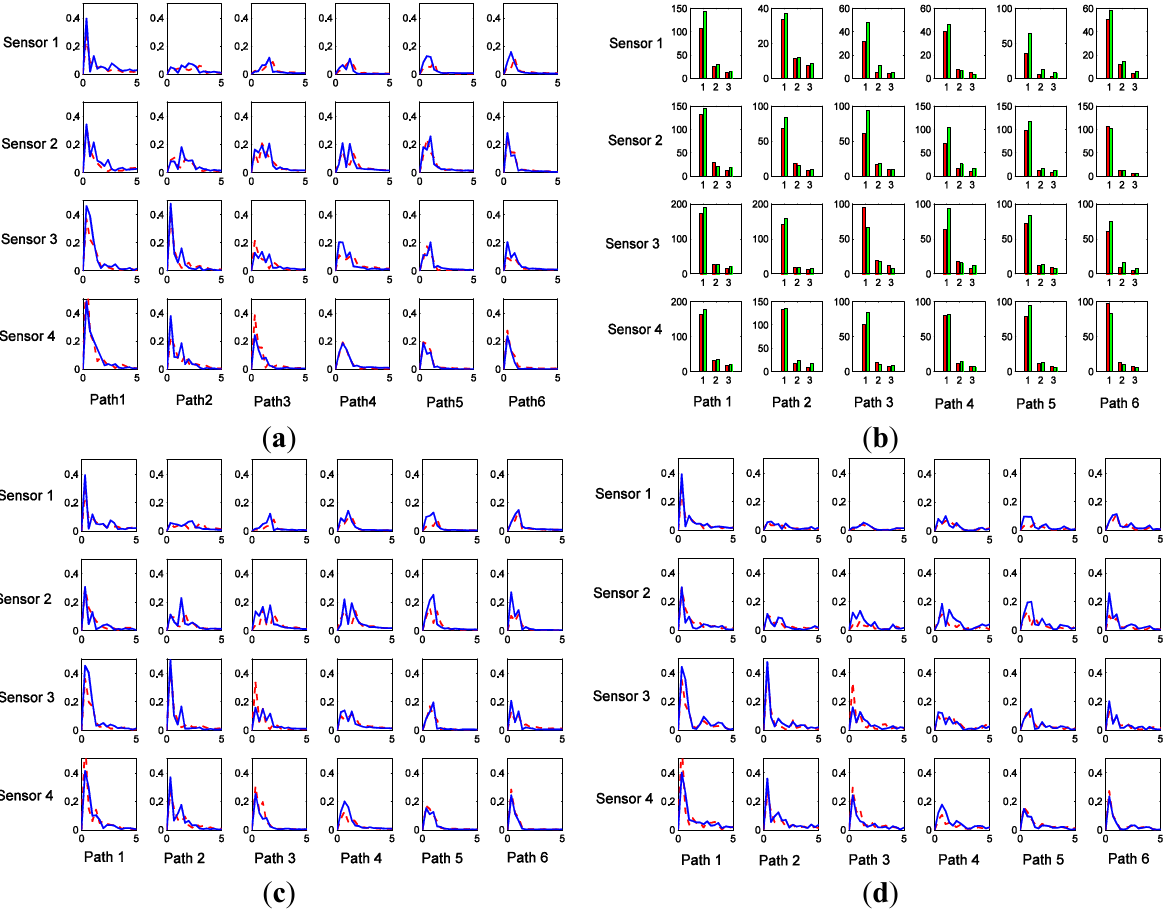
Figure 10. Feature extraction by different algorithms. ( a ) Feature extraction by FFT. ( b ) Feature extraction by STFT. ( c ) Feature extraction by WT. ( d ) Feature extraction by